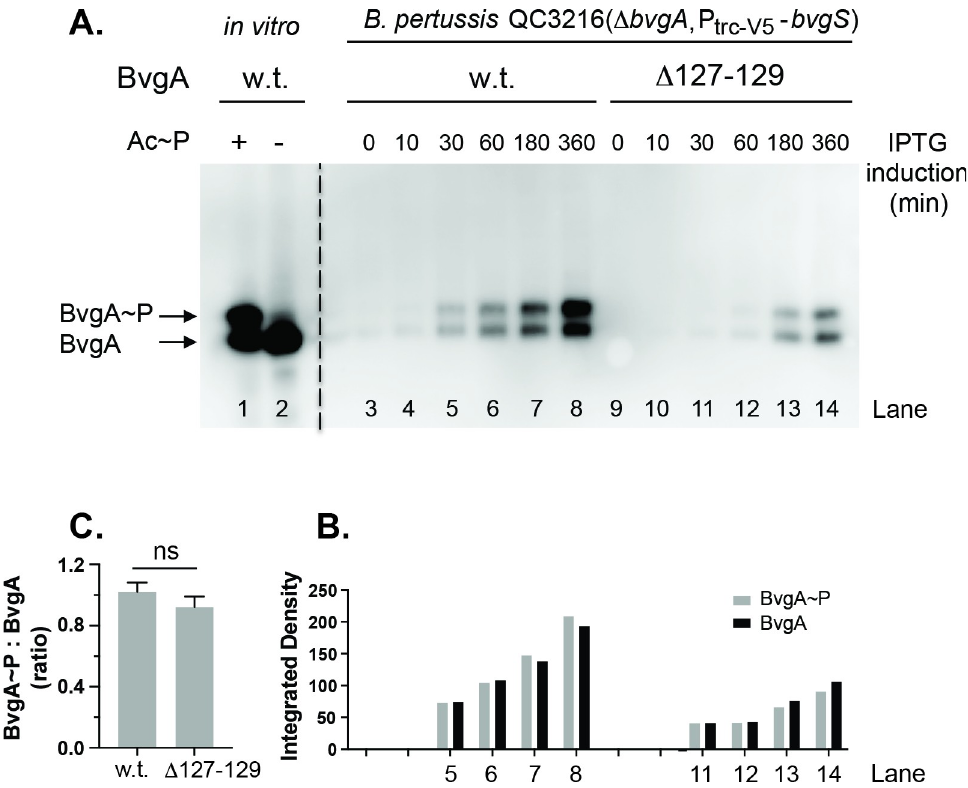
Fig 2. Kinetics of in vivo phosphorylation of wild type and Δ 127–129 BvgA. A. B . pertussis strain QC3216 harboring plasmids conferring expression of wild-type BvgA (pSS4893, lanes 3–8) and BvgA Δ 127–129 (pQC1894, lane 9–14), respectively, were grown in PLB liquid media, induced with 1 mM IPTG and sampled at various time points post induction. The collected samples were analyzed by Phos-tag gel electrophoresis, followed by Western blot with anti-BvgA detection, as previously described [9]. Control lanes contained 1 pmol of purified BvgA incubated in the presence (+, lane 1) or absence (-, lane 2) of acetyl phosphate as described previously [9]. B. The intensities of BvgA (black bar) and BvgA~P (grey bar) for lanes 5–8 and 11–14 were quantified and reported as integrated density using ImageJ software. C. The quantitative intensities derived from four IPTG-induction time points (30 min, 60 min, 180 min and 360 min) in panel B were used to calculate the ratios of BvgA~P to BvgA for the wild type and the mutant BvgA, respectively, and to obtain the means, standard deviations, as indicated by error bars, and statistical analysis by one-way ANOVA. Outcome of the latter analysis is presented using the symbol: ns, P >